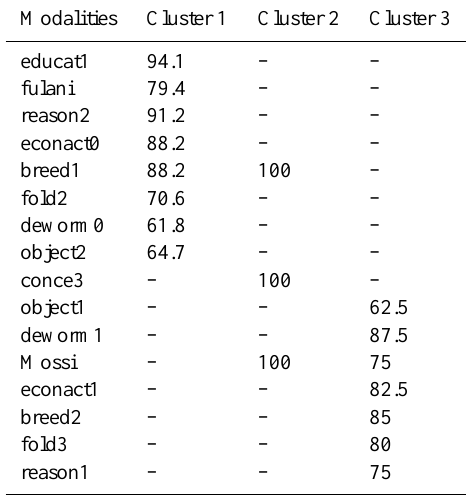
Figure 4. Graphic representation clusters on axis 1 and 2 (the num- bers correspond to breeders’ identifiers). Table 4. Degrees of statistic link between variables and the three first axes.